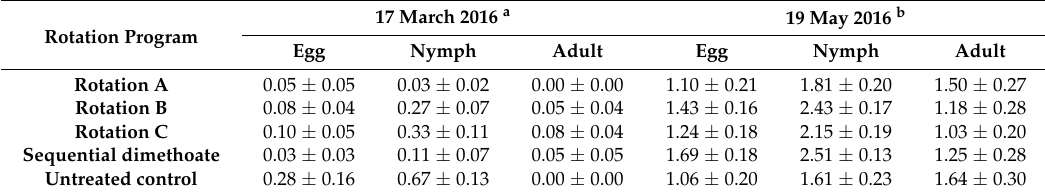
Table 3. Average density rankings ( ± SE) of Asian citrus psyllid, Diaphorina citri , egg, nymph, and adult counts upon plot establishment and immediately prior to first treatment application.